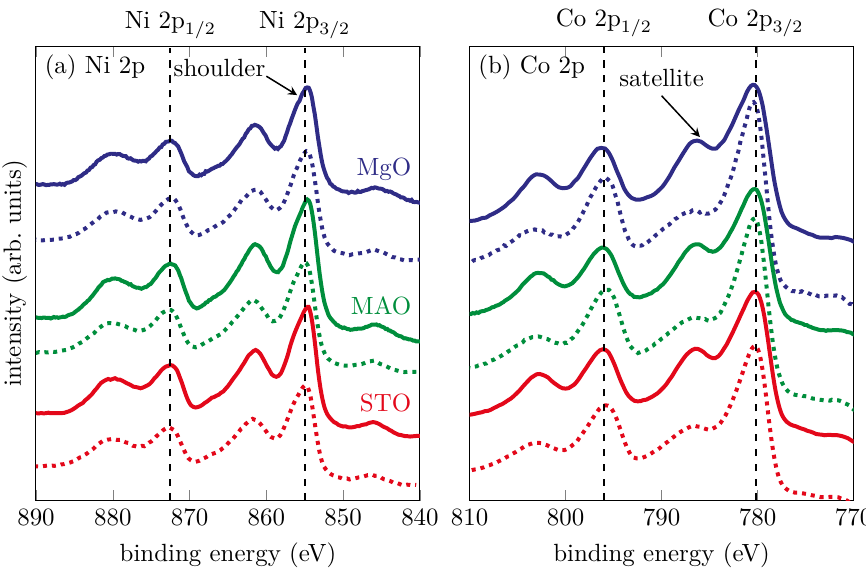
Figure 3. Soft-XP spectra of the ( a ) Ni 2p and ( b ) Co 2p core-levels. The solid lines represent the films prepared with O 2 while the dashed lines represent the films prepared with O ∗ . The vertical dashed lines represent the literature values for the respective main spin-orbit split peaks. The highlighted satellite is less distinguished for the films prepared with O ∗